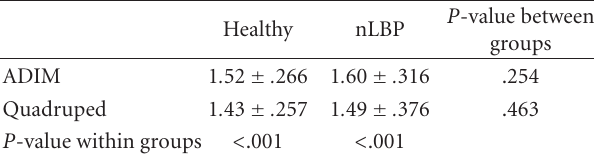
Table 2: Activation ratios comparing nLBP to healthy